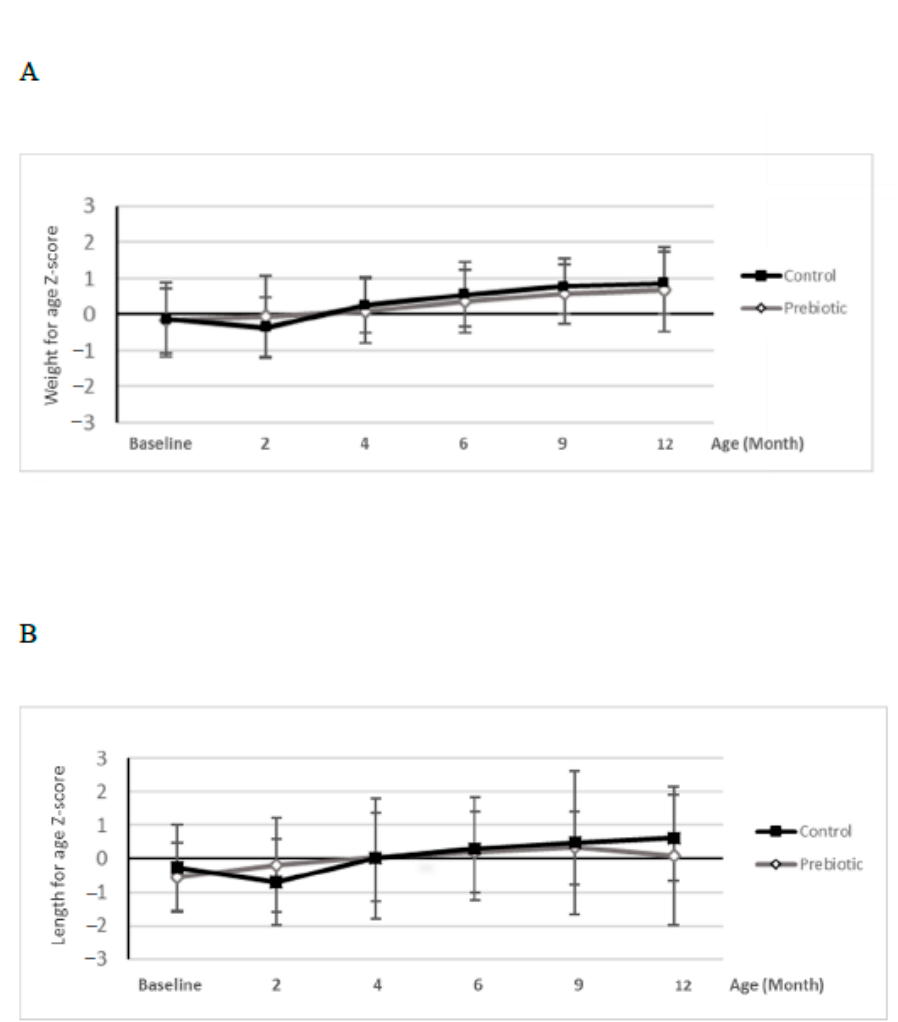
Figure 2. Mean data for weight–for–age ( A ) and length–for–age ( B ) WHO growth standard Z–scores for prebiotic and control groups during the course of the study (until 12 months of age). Grey lines containing white rhombs represent the prebiotic group, while black lines with black squares represent the control group. Lines represent Standard Deviation (SD). There were no group-related differences.